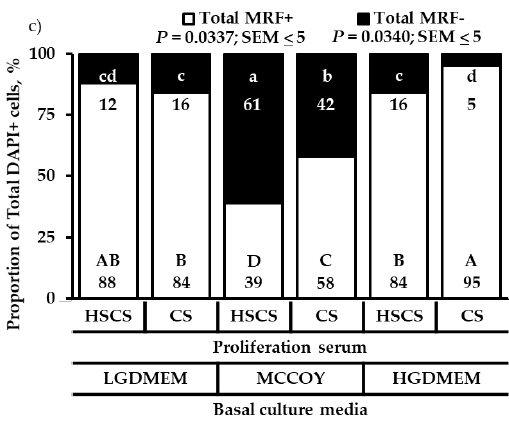
Figure 2. The effect of basal culture media and proliferation sera on total DAPI+ cells ( a ), total MRF+ and total MRF- cells ( b ), and proportions of total MRF+ or total MRF- cells to total DAPI+ cells ( c ) at 72 h post-plating. Cells were cultured in either low glucose Dulbecco’s Modified Eagles medium (LGDMEM), McCoy’s 5A (MCCOY), or high glucose Dulbecco’s Modified Eagles medium (HGDMEM) supplemented with either 5% horse serum + 10% chicken serum (HSCS) or 15% chicken serum (CS). a–d; A–D Means with different superscripts describe a difference p ≤ 0.05 and were generated from the pairwise mean comparison analysis.